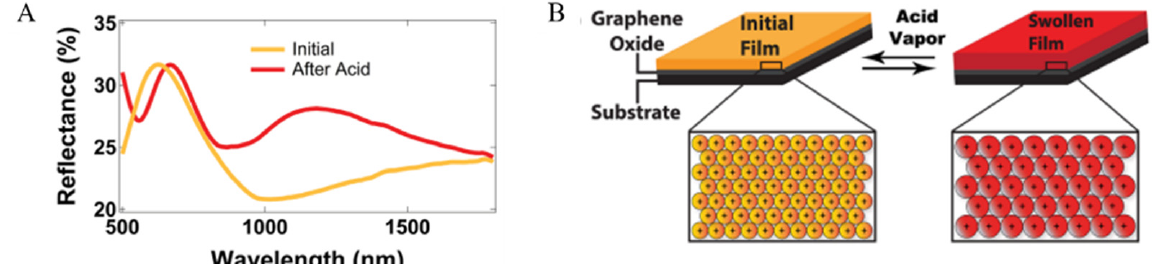
Figure 4. ( A ) The response changes of the reflection spectrum of the RA1 film layer before and after the acetic acid treatment; ( B ) Changes in the electrostatic state of RA1 nanoparticles before and after the acetic acid treatment and the expansion of the film layer [33]. Copyright 2013, WILEY-VCH Verlag.